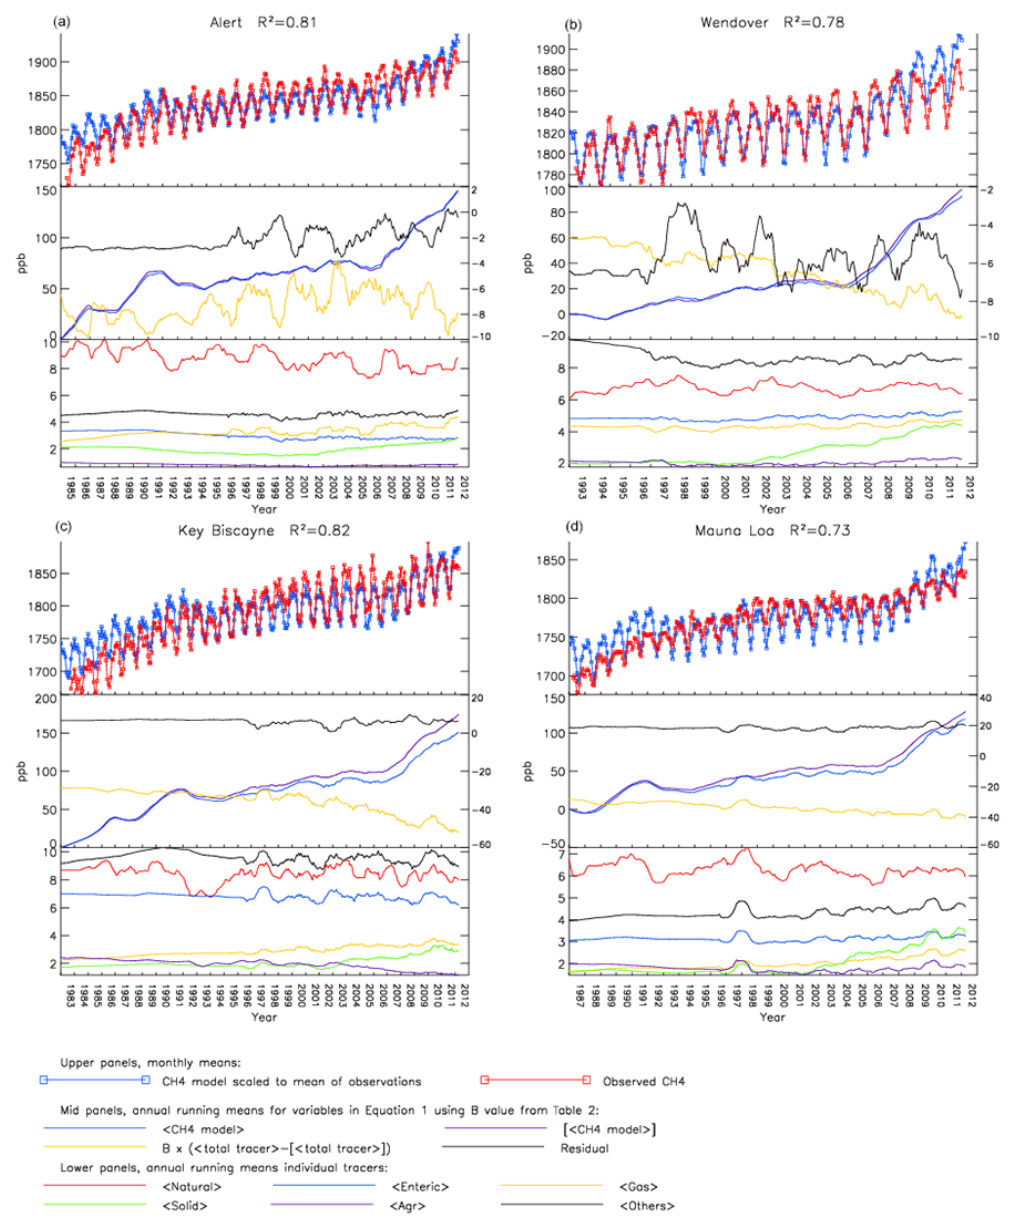
Figure 7. Evolution of CH 4 and tracers at stations ( a : Alert, b : Wendover, c : Key Biscayne, d : Mauna Loa) in or near North America. See Fig. 6 caption for further